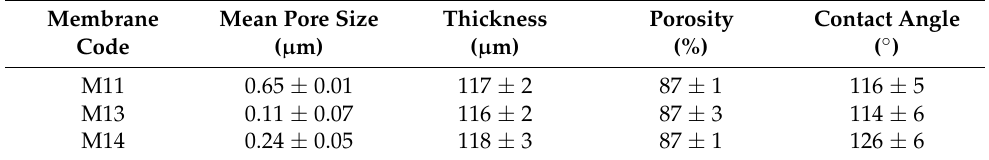
Table 6. Mean pore size, thickness, porosity and contact angle of the M11, M13 and M14 membranes.